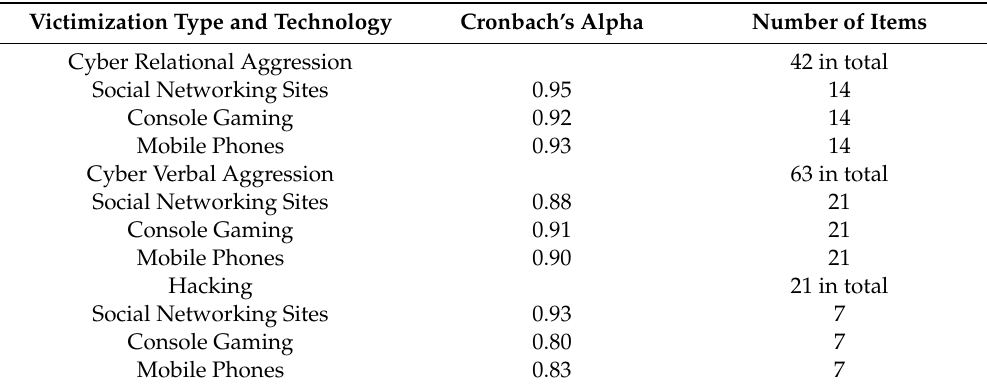
Table 1. Cronbach’s alphas of all victimization behaviors and